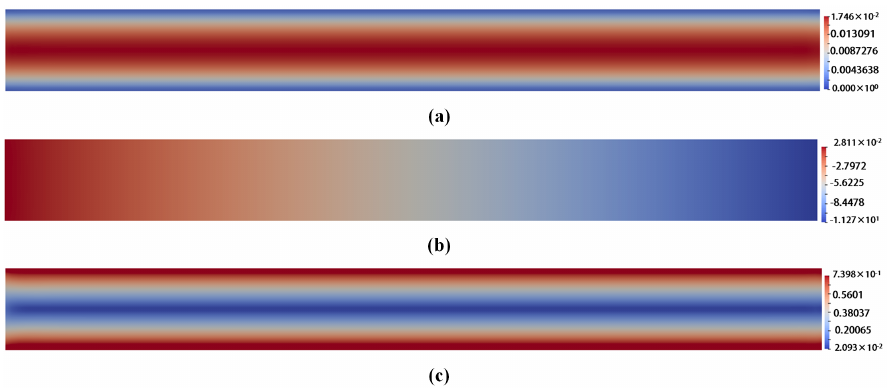
Figure 5. The snapshots: ( a ) of the velocity field uuu for Hooke model with l = 2, ρ = 0.1, N BCF = 800 at t = 1.999185; ( b ) of the pressure field p for Hooke model with with l = 2, ρ = 0.1, N BCF = 800 at t = 1.999185; and ( c ) of the stress tensor field τττ p for Hooke model with with l = 2, ρ = 0.1, N BCF = 800 at t = 1.999185.